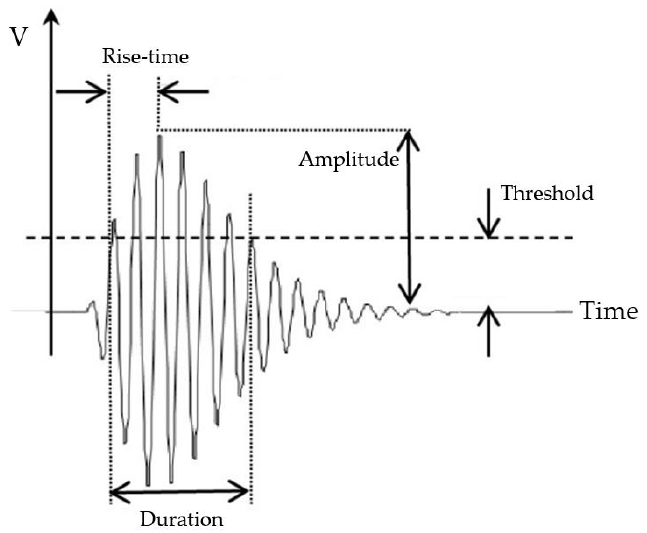
Figure 5. Typical AE transient signal. V: Voltage.